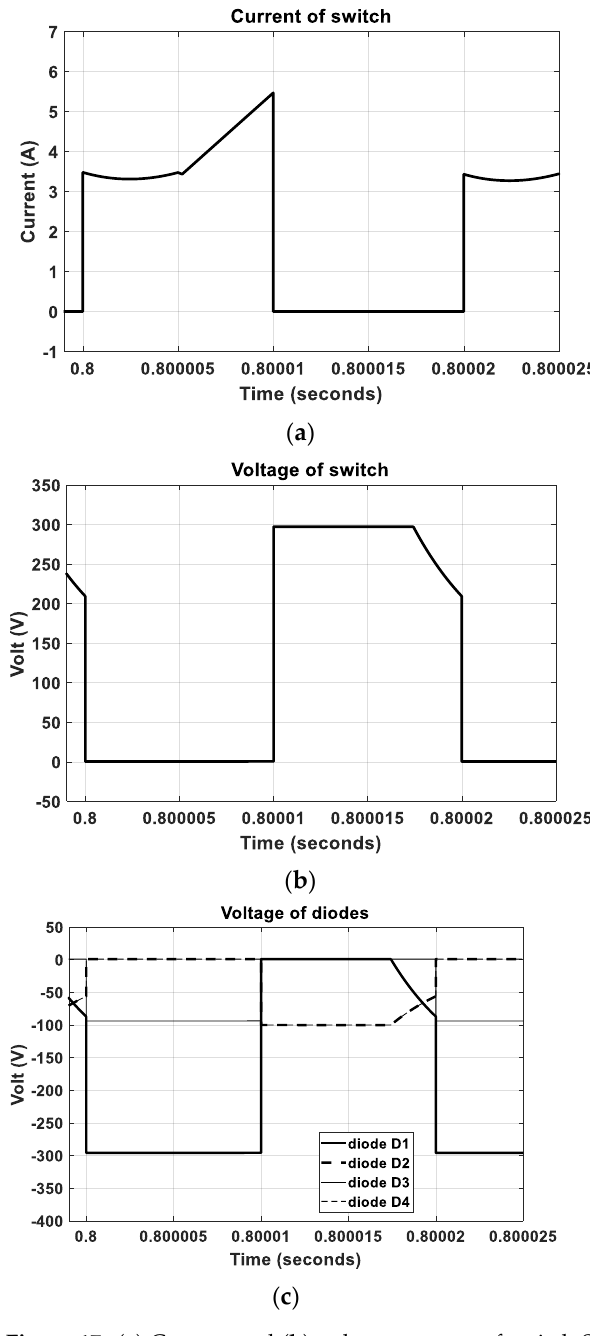
Figure 17. ( a ) Current and ( b ) voltage stresses of switch S1; ( c ) voltage waveforms across diodes 𝐷 1 − 𝐷 4 in the proposed boost converter.